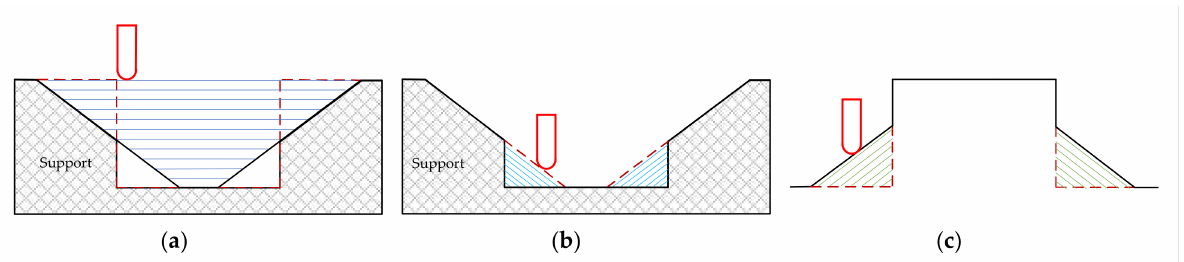
Figure 4. Three stages of forming: ( a ) the first stage; ( b ) the second stage; ( c ) the third stage.